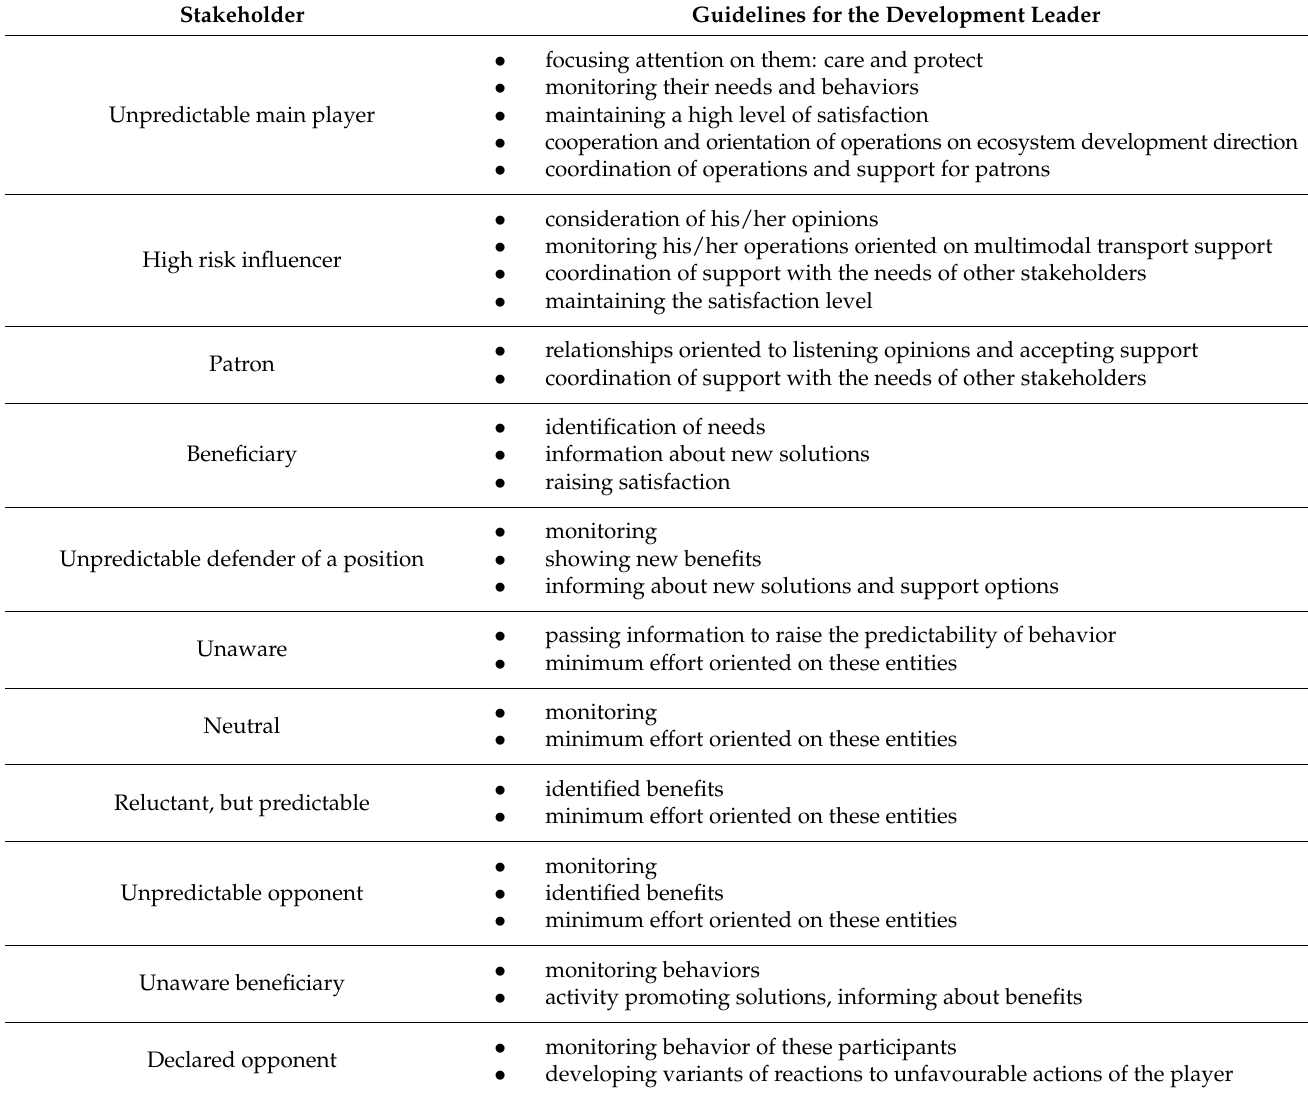
Table 7. Guidelines for the development